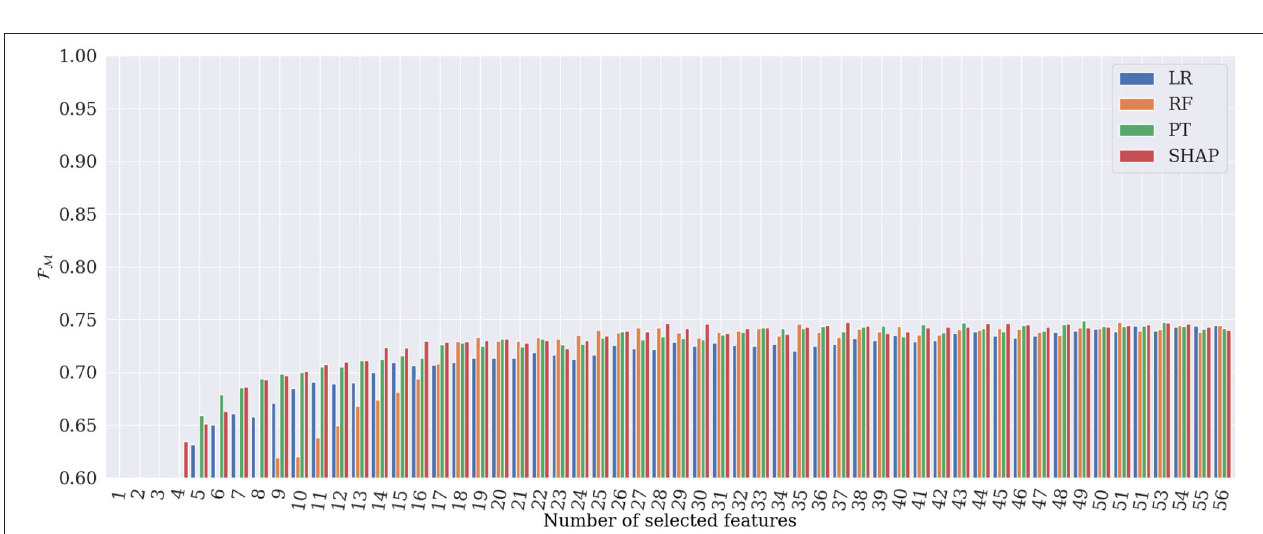
FIGURE 6 | Results of heart rhythm classification in terms of F µ , by RF classifier applied to only the most important features. SHAP generates the best classification results based on only 28 features.